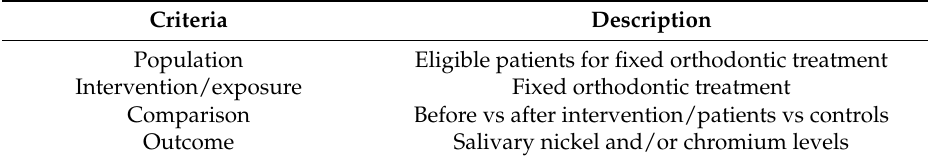
Table 1. Population, intervention/exposure, comparison, and outcome of the included